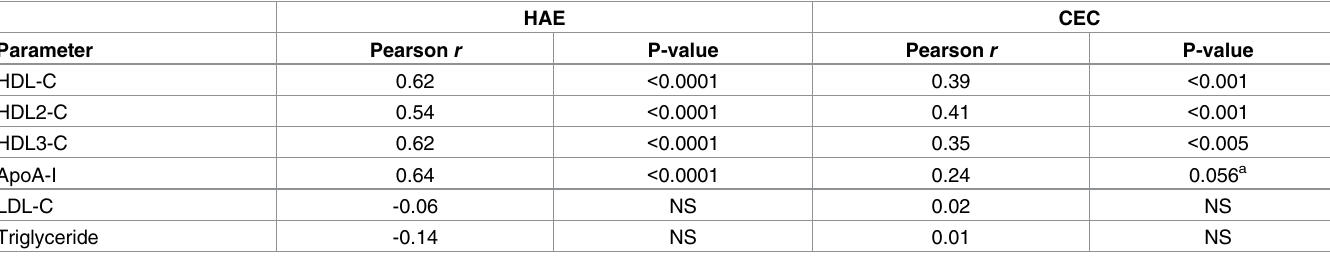
Table 2. Pearson correlation of HAE and ABCA1-specific CEC with lipid and lipoprotein parameters. HAE